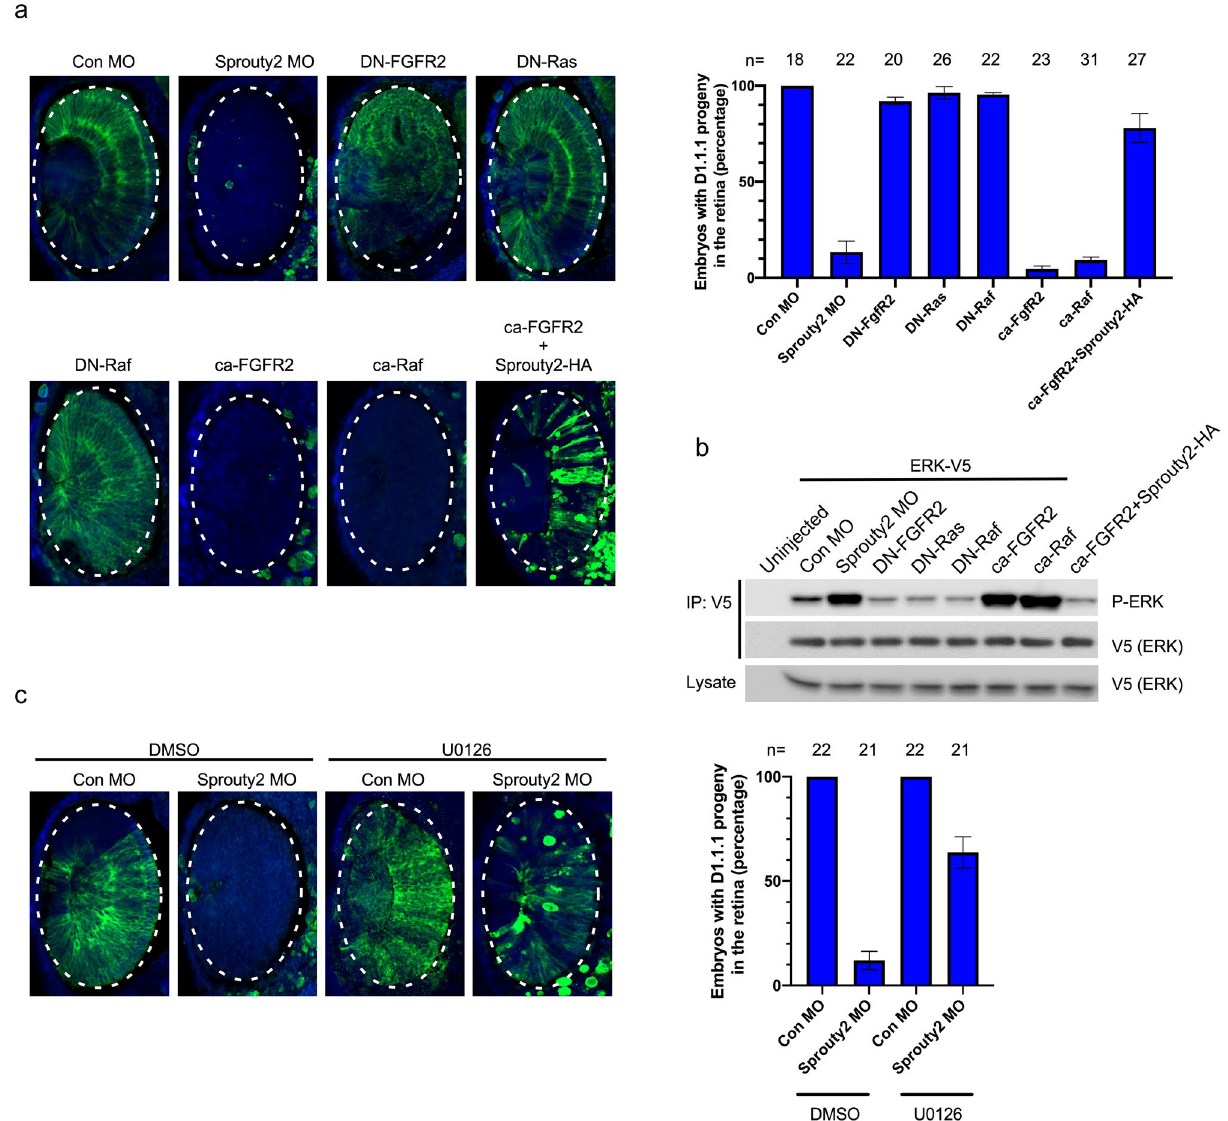
Figure 3. Over-activity of MAPK inhibits positioning of retinal progenitors within retina. ( a ) The indicated morpholinos or RNAs were injected with GFP mRNA into D1.1.1 blastomere at 32 cell stage. Embryos were then sectioned and immunostained with GFP antibody (Green) at stage 33. Images were taken of the eye region. The retina was outlined with an oval dotted line. Histograms represent the percentage of embryos with D1.1.1 progeny (GFP positive signals) within the retina from three biological repeats. Quantification with one- way ANOVA (Sidak’s multiple comparison), P < 0.0001, Error bars indicate ± SD. ( b ) Embryos were injected with RNAs or Morpholinos along with ERK-V5 RNA into D1.1.1 blastomere at 32 cell stage and lysed at late neurula stage for immunoprecipitation with v5 agarose beads. Precipitates were then immunoblotted with phospho-ERK and total ERK antibodies. Three independent repeats were performed. ( c ) D1.1.1 blastomere was injected with control MO or Sprouty2 MO along with GFP mRNA at 32 cell stage. The injected embryos were either treated with DMSO or U0126 from late gastrula to late neurula stage. Embryos were then sectioned and immunostained with GFP antibody (Green) at stage 33. Histograms represent the percentage of embryos with D1.1.1 progeny (GFP positive signals) within the retina from three biological repeats. Quantification with one- way ANOVA (Sidak’s multiple comparison), P < 0.0001, Error bars indicate ± movement into the eye field by interacting with Dsh2 and co-opting the PCP pathway 9 . Thus, FGFR restricts eprhinB1 driven cell movement via the Dsh2/PCP pathway. FGF also activates multiple intracellular cascades during embryonic development 27,28 . The MAPK/ERK path- way (also known as the Ras–Raf–MEK–ERK pathway) is one of the well-known downstream cascades of the FGFR. However, whether this pathway is involved in regulating the positioning of retinal progenitor within retina is still largely unknown. Sprouty2, a well-studied negative feedback regulator that controls the Ras–Raf–MAPK pathway at multiple levels is an ideal candidate for understanding the role of MAPK pathway in the positioning